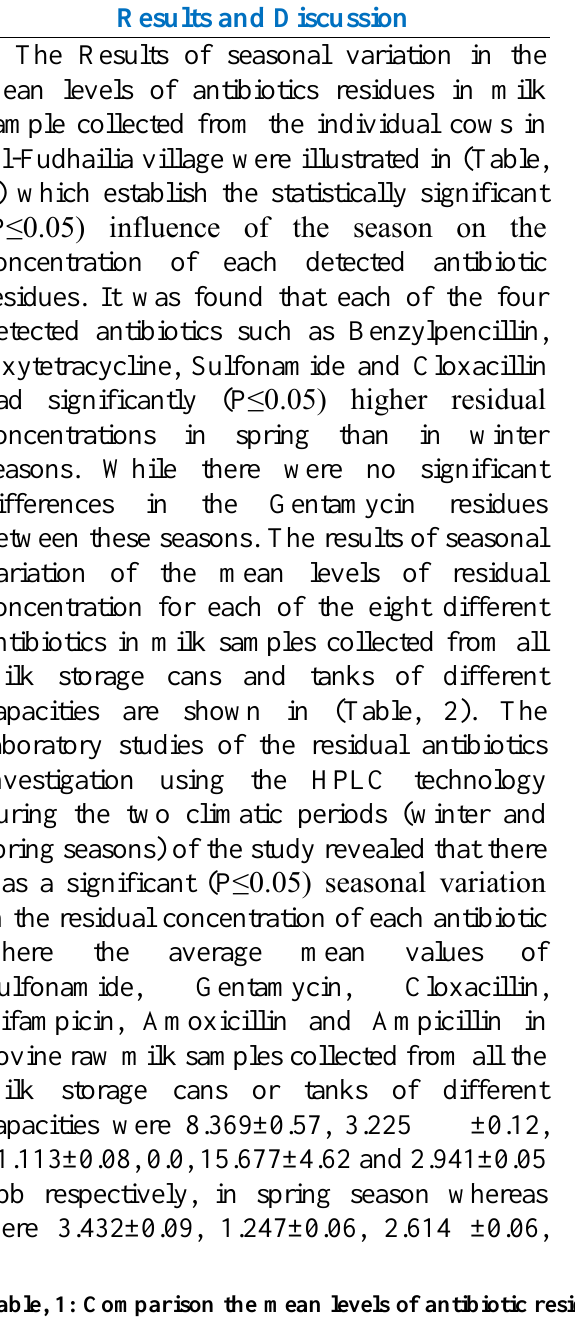
Table, 1: Comparison the mean levels of antibiotic residues (ppb) in milk samples collected from the individual cows in AL-Fudhailia village between the winter and spring seasons.